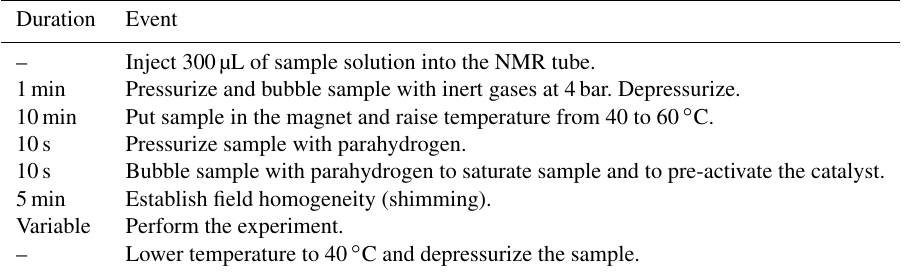
Table 1. Experimental procedure for gem-PHIP experiments. Duration Event Inject 300µL of sample solution into the NMR tube. 1min Pressurize and bubble sample with inert gases at 4bar. Depressurize. 10min 10s Pressurize sample with parahydrogen. 10s Bubble sample with parahydrogen to saturate sample and to pre-activate the catalyst. 5min Establish field homogeneity (shimming). Variable Perform the